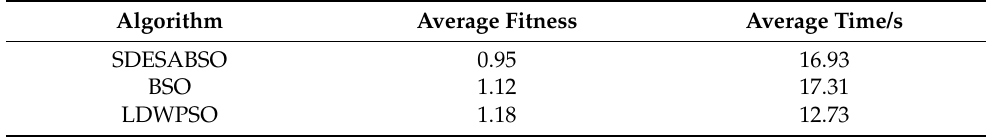
Table 4. Comparison of average fitness values.